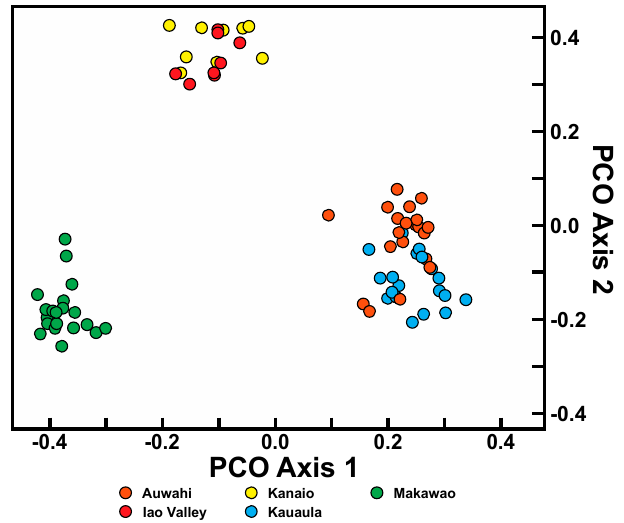
Figure 3. Principal coordinate analysis of combined RAPD and ISSR dataset using all scored markers for Chrysodracon auwahiensis . PCO axis 1 and 2 accounted for 17.1% and 11.2% of the variation, respectively.